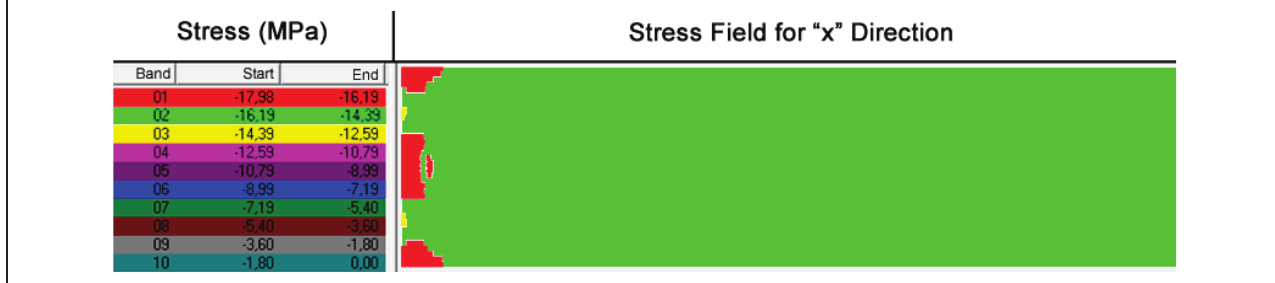
Figure 9 – Normal stress field at the instant of loading – Case